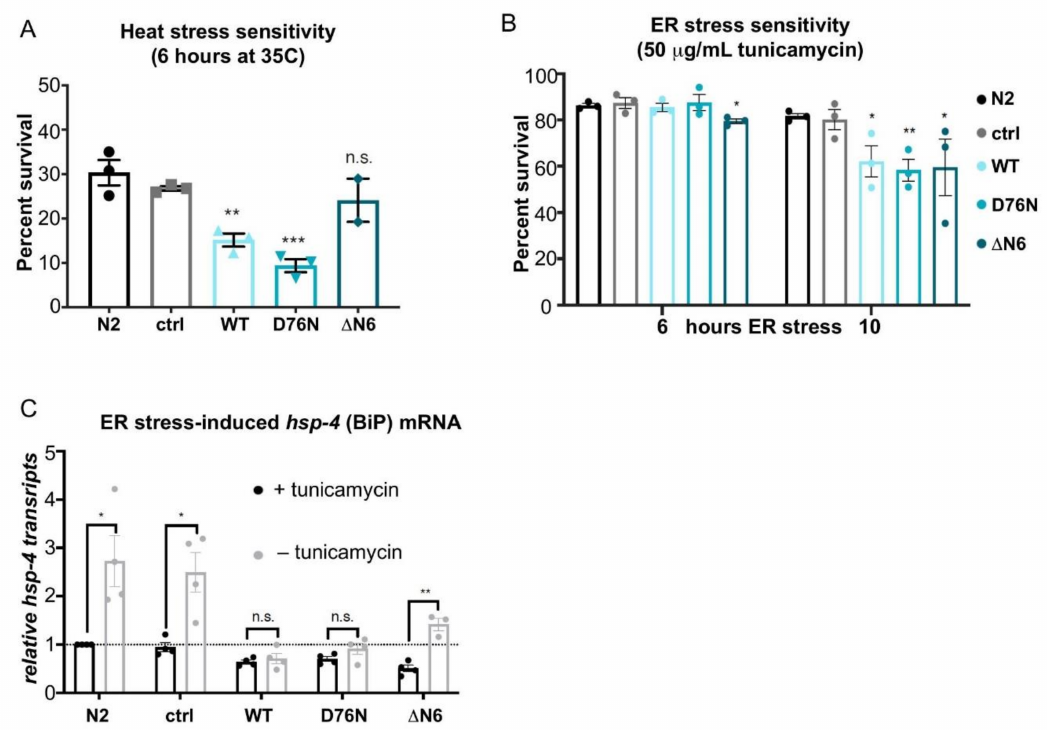
Figure 4. Heat stress and ER stress sensitivity and response. ( A ) Survival rates of N2, control, WT β 2 m, D76N β 2 m and ∆ N6 β 2 m Day 1 adults after heat stress. Animals were placed onto seeded NGM plates, incubated in a 35 for 6 h, and scored for survival after a 16-h recovery at 20 ◦ C. Three independent experiments were performed ( n = 50 per experiment). Error bars indicate S.E.M. A Student’s t test was performed to assess significance: ** p < 0.005, *** p < 0.001, n.s. = not significant. ( B ) ER stress survival rates of N2, control, WT β 2 m, D76N β 2 m and ∆ N6 β 2 m Day 1 adults exposed to 50 µ g/mL tunicamycin for 6 and 10 h. Survival was scored after 16 h of recovery. Three independent experiments were performed ( n = 40 animals per experiment). Error bars represent SEM; a Student’s t test was performed to calculate significance compared to N2: * p < 0.05; ** p < 0.01. ( C ) hsp-4 transcript levels with or without tunicamycin treatment in Day 1 adult control, β 2m WT β 2 m, D76N β 2 m and ∆ N6 β 2 m animals compared to N2. Animals were incubated in 50 µ